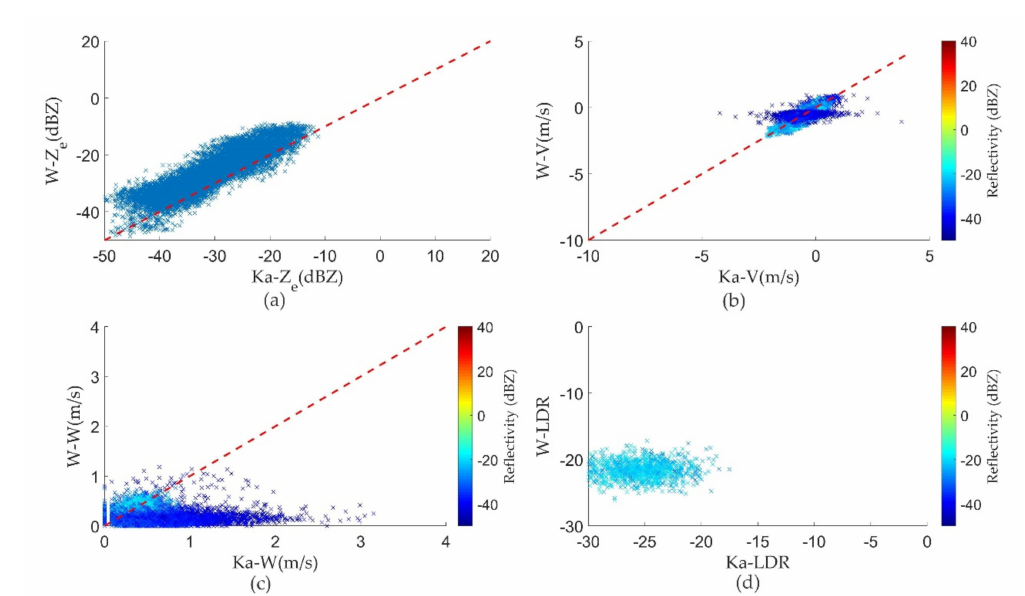
Figure 11. The measured ( a ) Z e , ( b ) V , ( c ) W and ( d ) LDR by the Ka-band radar vs. the W-band radar on 3 March 2020. The reflectivity from the Ka-band radar in ( b – d ) is also illustrated by colors. The red dotted line is the 1:1 line. Here, only the data that both the Ka-band radar and W-band radar have obtained are